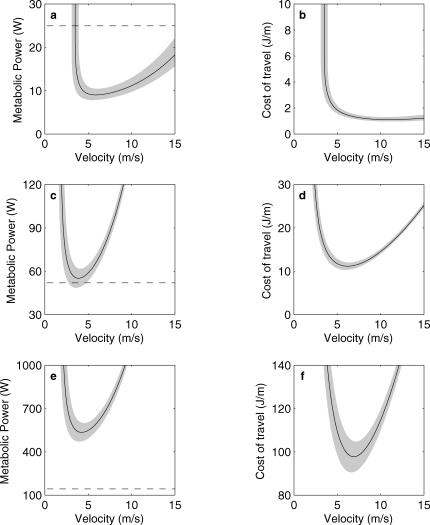
Power Curves(A, B) R. n. cinerascens, (C, D) Tupuxuara sp., and (E,F) Thalassodromeus in flapping flight. Plots are of horizontal flight speed versus metabolic flight costs in ground effect with the mandible immersed to the depth indicated in Table 1 (A, C, and E), and metabolic costs per metre travelled (B, D, and F). Shaded areas bound the limits of the high- and low-power estimates from the sensitivity analysis. The horizontal line on A, C, and E indicates estimated available metabolic power (47.126M
0.605) [29])